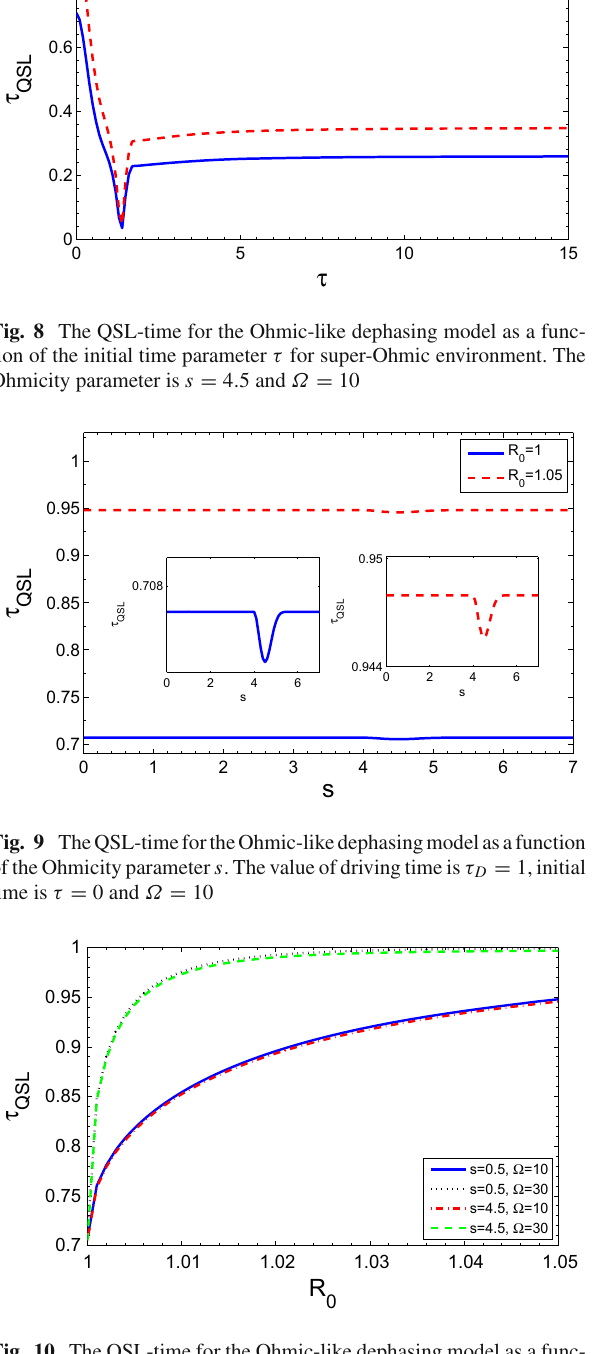
is increased(decreased) by increasing(decreasing) quantum coherence [23]. Figure 8 represents the QSL-time as a func- tion of the initial time parameter τ , when Ohmicity